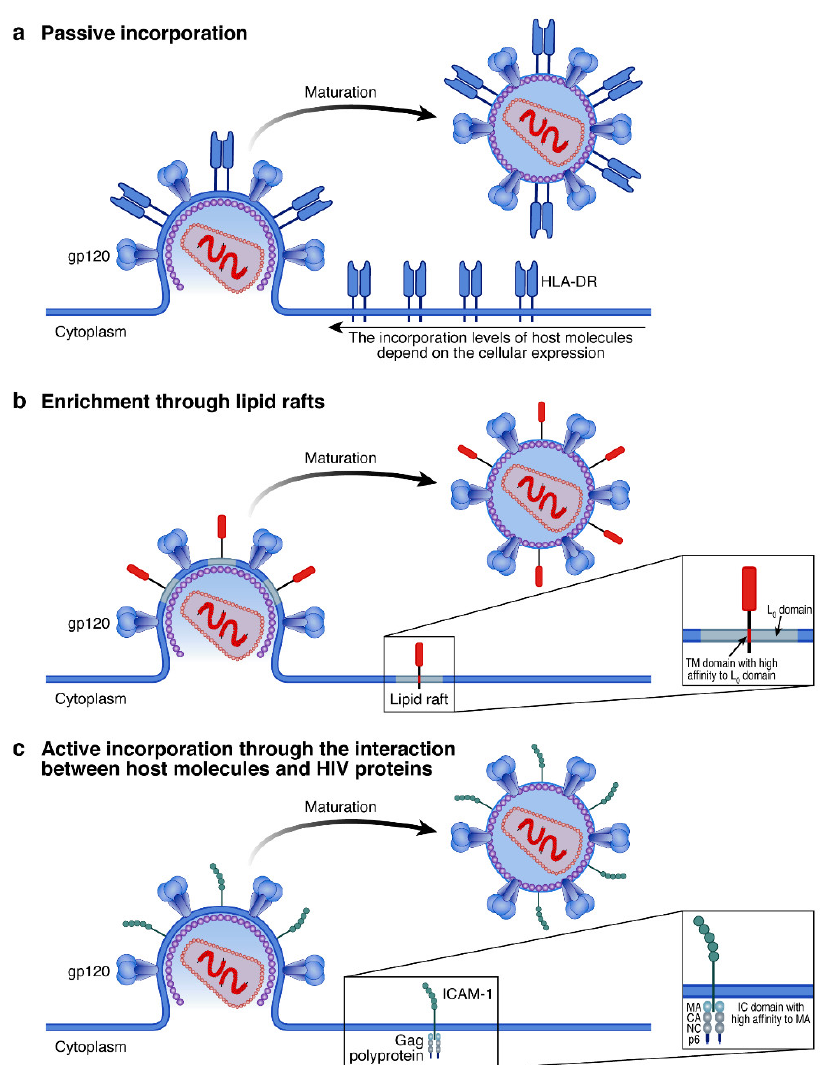
Figure 2. Mechanisms of host protein incorporation into HIV virions: ( a ) passive incorporation; no differences in protein (e.g., HLA-DR in blue) levels between the cellular and viral envelope: and ( b ) lipid composition remodeling (grey fragments) and surface curvature promote the incorporation of specific proteins (e.g., CD59 in red) that have a transmembrane domain with high affinity to the liquid-order phase generated by HIV virions. ( c ) Interaction between HIV proteins (e.g., Gag polyprotein) (violet) and the intracytoplasmic tail of host proteins (e.g., ICAM-1 in green).